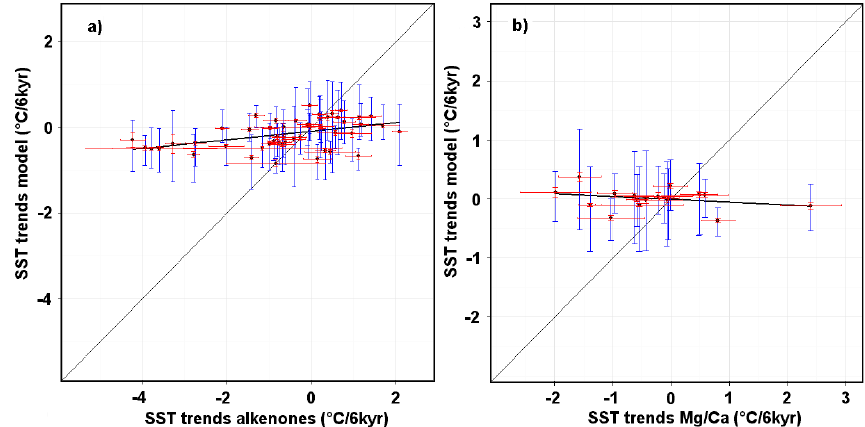
Fig. 6. (a) Alkenone-based temperature trends plotted against annual mean SST trends derived from the ECHO-G model. As (a) , but for Mg/Ca-based temperature trends. The solid thick lines represent the 1:1 line for a match of modelled and reconstructed trends. The thin lines represent the regression of modelled and reconstructed trends. Red bars represent the standard error of the slope, and blue bars show the modelled seasonal range (maximum and minimum seasonal